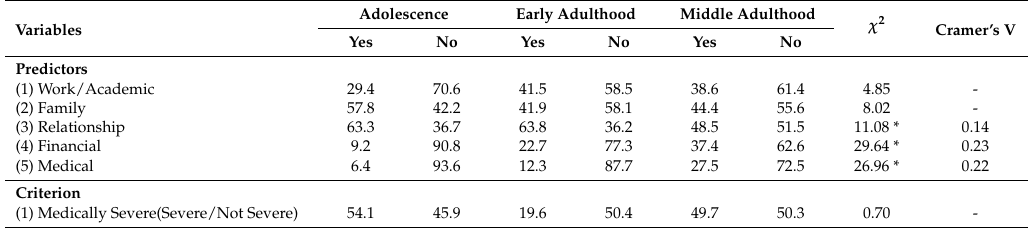
Table 1. Percentage of Participants with Work, Family, Relationship, Financial, and Medical Problems, and Medically Severe Suicide